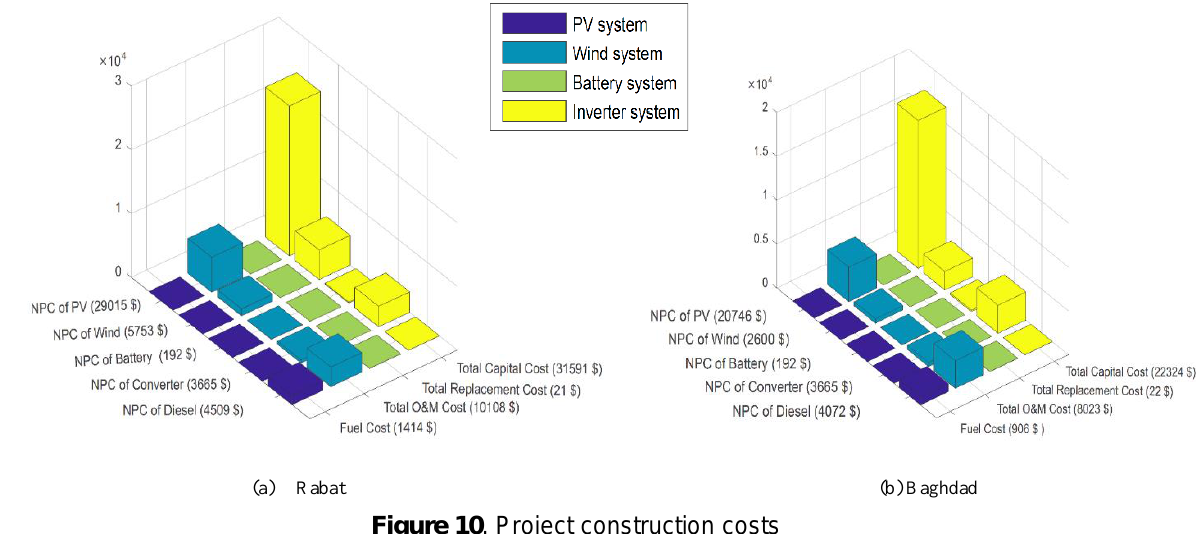
Figure 10 . Project construction